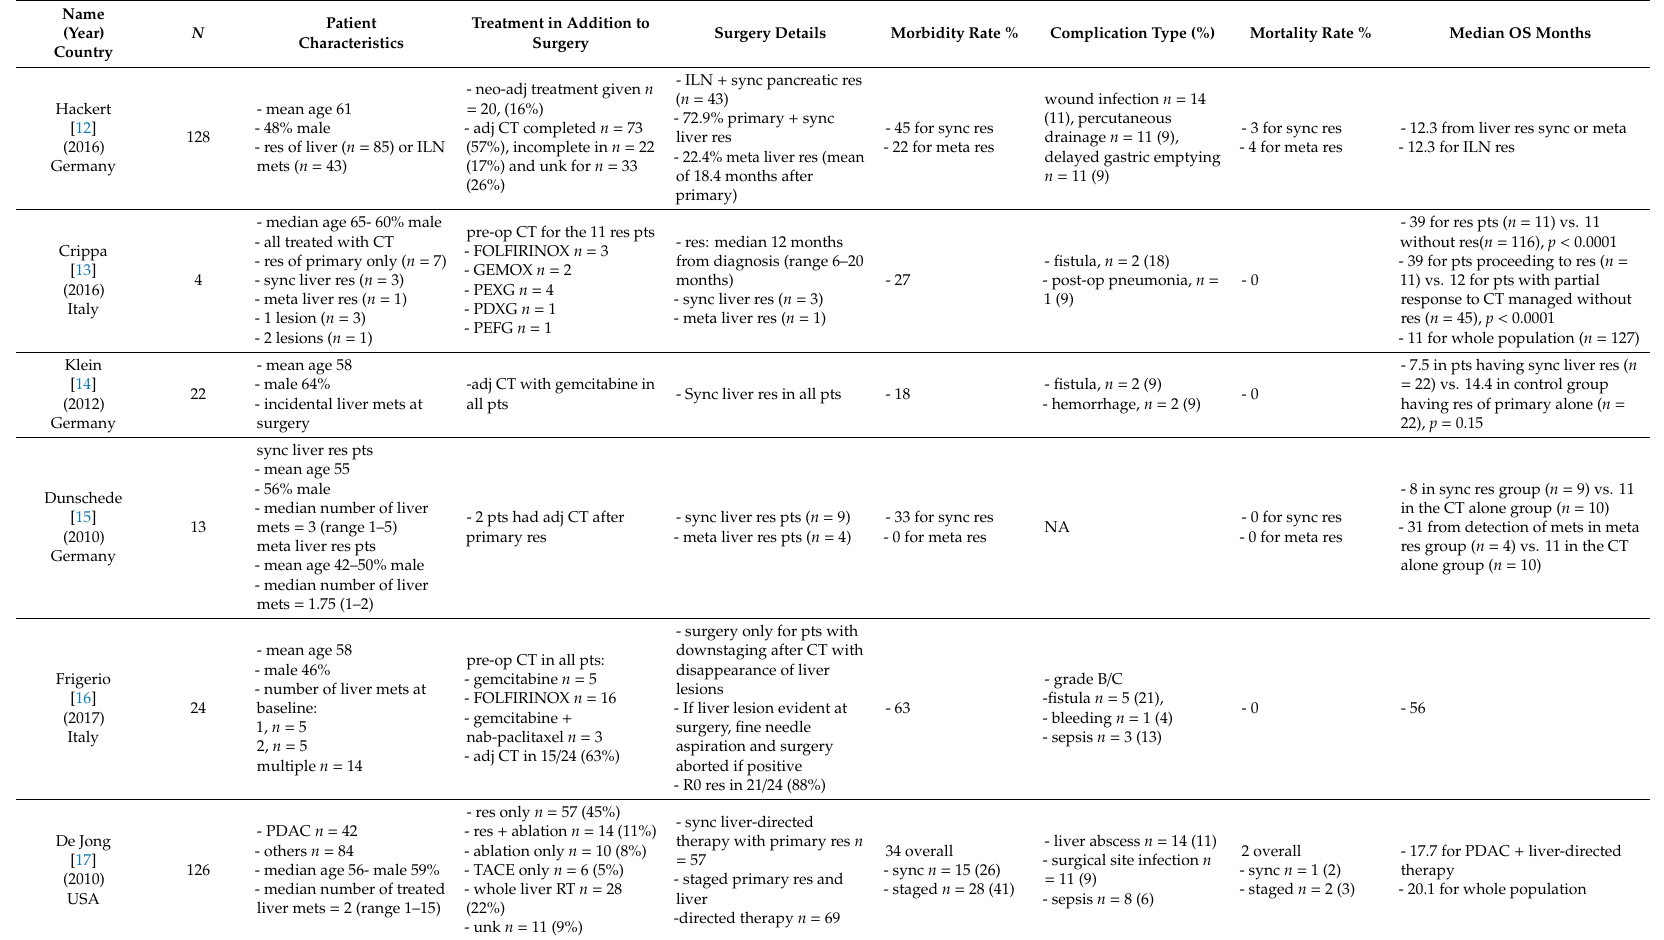
Table 1. Studies evaluating liver metastasectomy in pancreatic